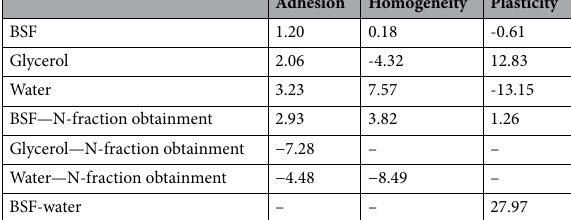
Table 7. Coefficient estimation (coded factors). Standard error =